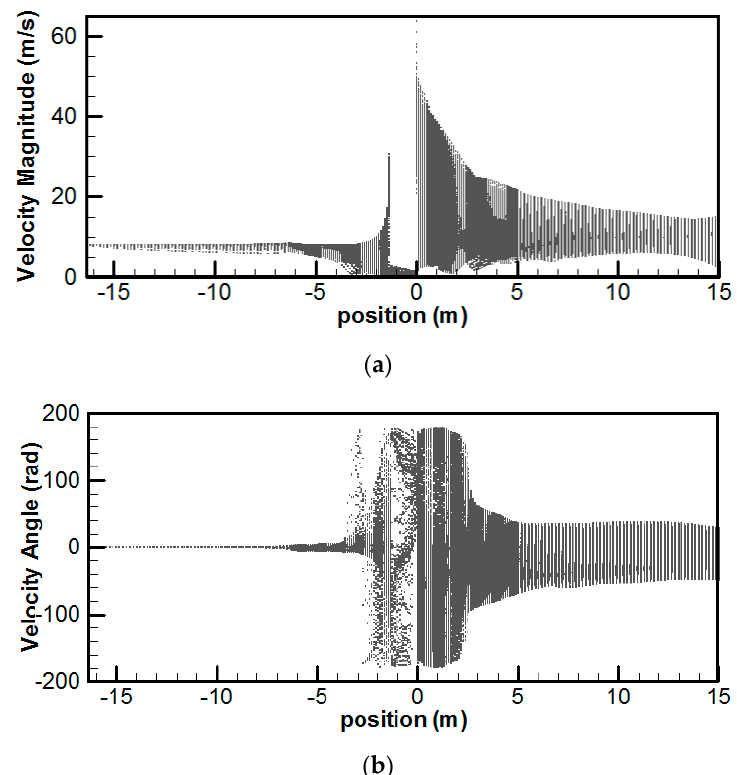
Figure 12. Velocity magnitude and velocity angle in the intake and return airways. ( a ) Velocity magnitude in the intake and return airways; ( b ) Velocity angle in the intake and return airways.